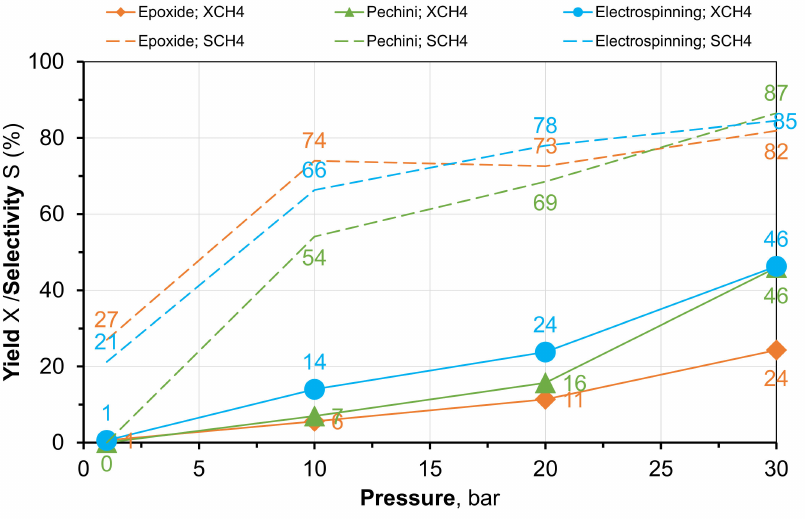
Figure 2. Methanation of CO 2 over fresh cobalt–cerium bimetallic oxides at 300 ◦ C: pressure and method effect on the yield to CH 4